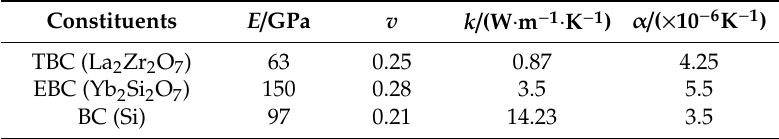
Table 1. Thermal-mechanical properties of the constituents in composites coating.